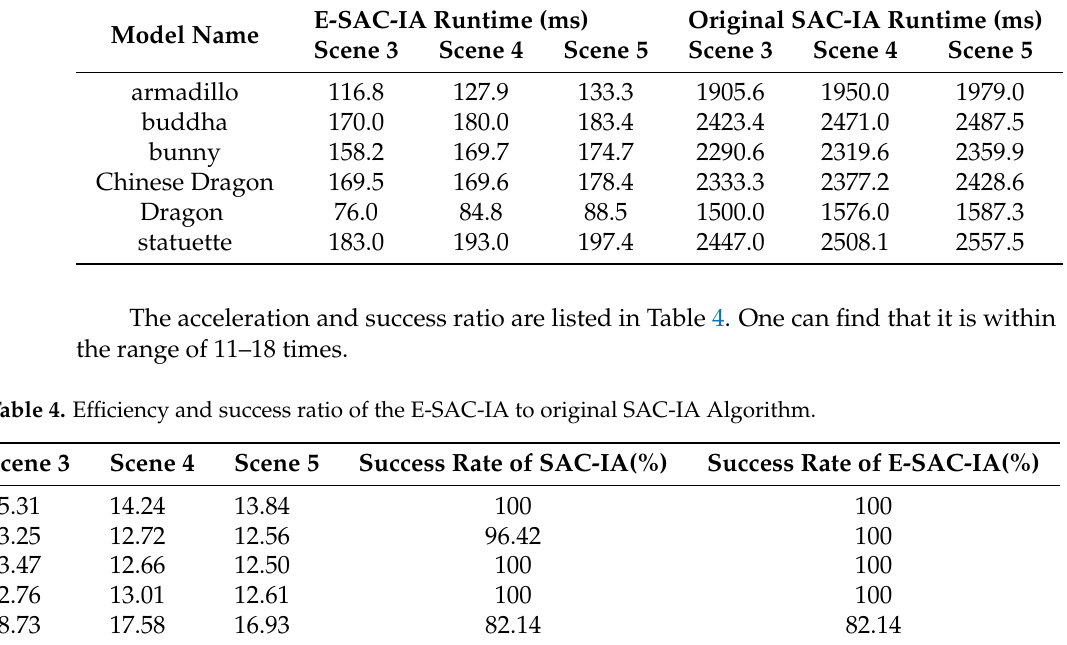
Table 3. Recognition time of E-SAC-IA and Original SAC-IA Algorithm.